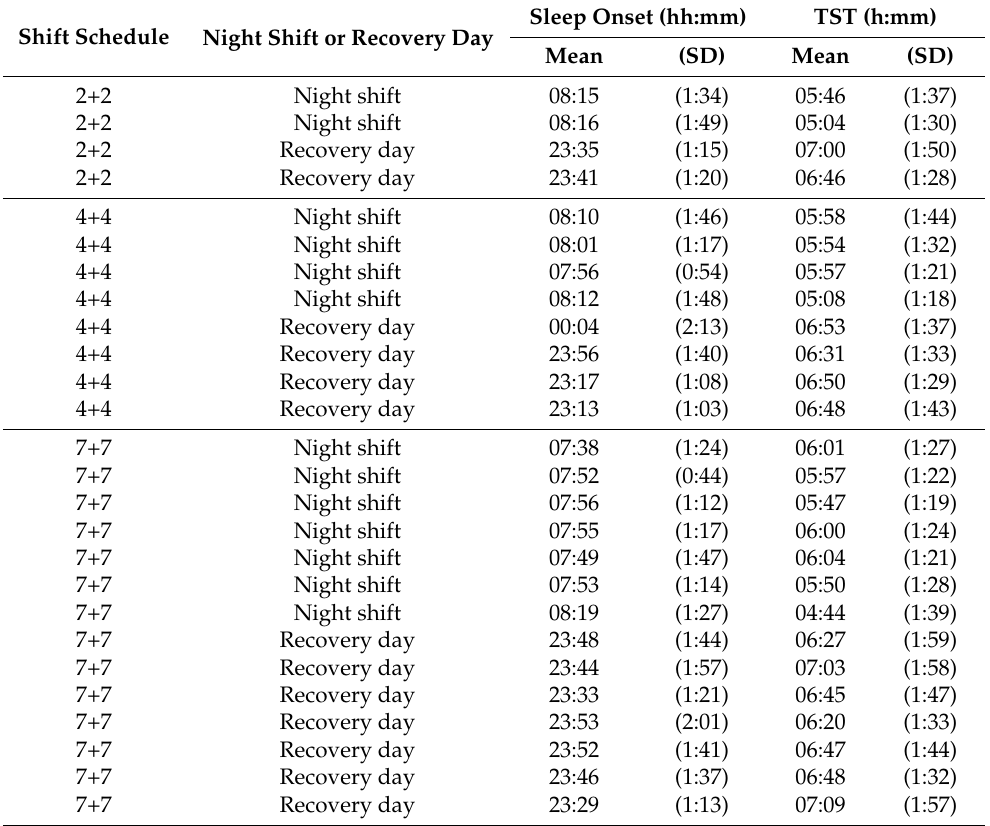
Table 2. Sleep onset and mean total sleep time (TST) for every day in the three different work schedules. TST (incl. naps) was assessed by